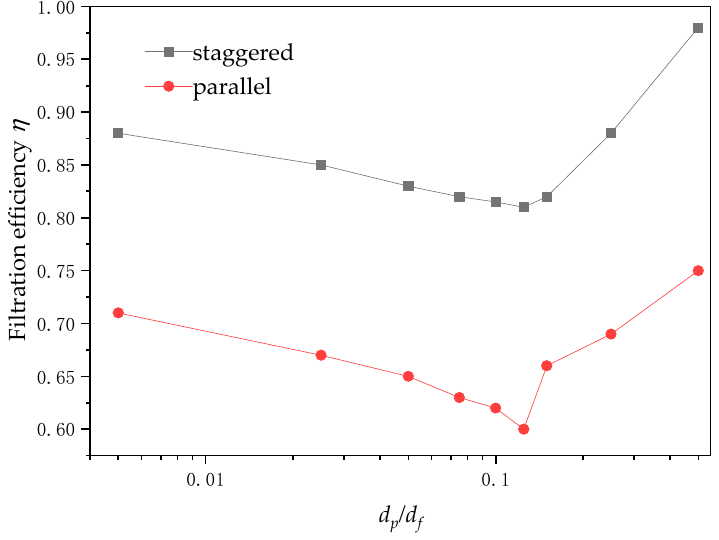
Figure 21. The relationship between filtration efficiency and particle size of parallel and staggered structures.